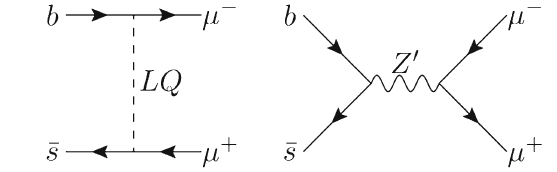
Fig. 14.1 Feynman diagrams for Z (cid:3) and leptoquarks mediating b → s μ + μ −